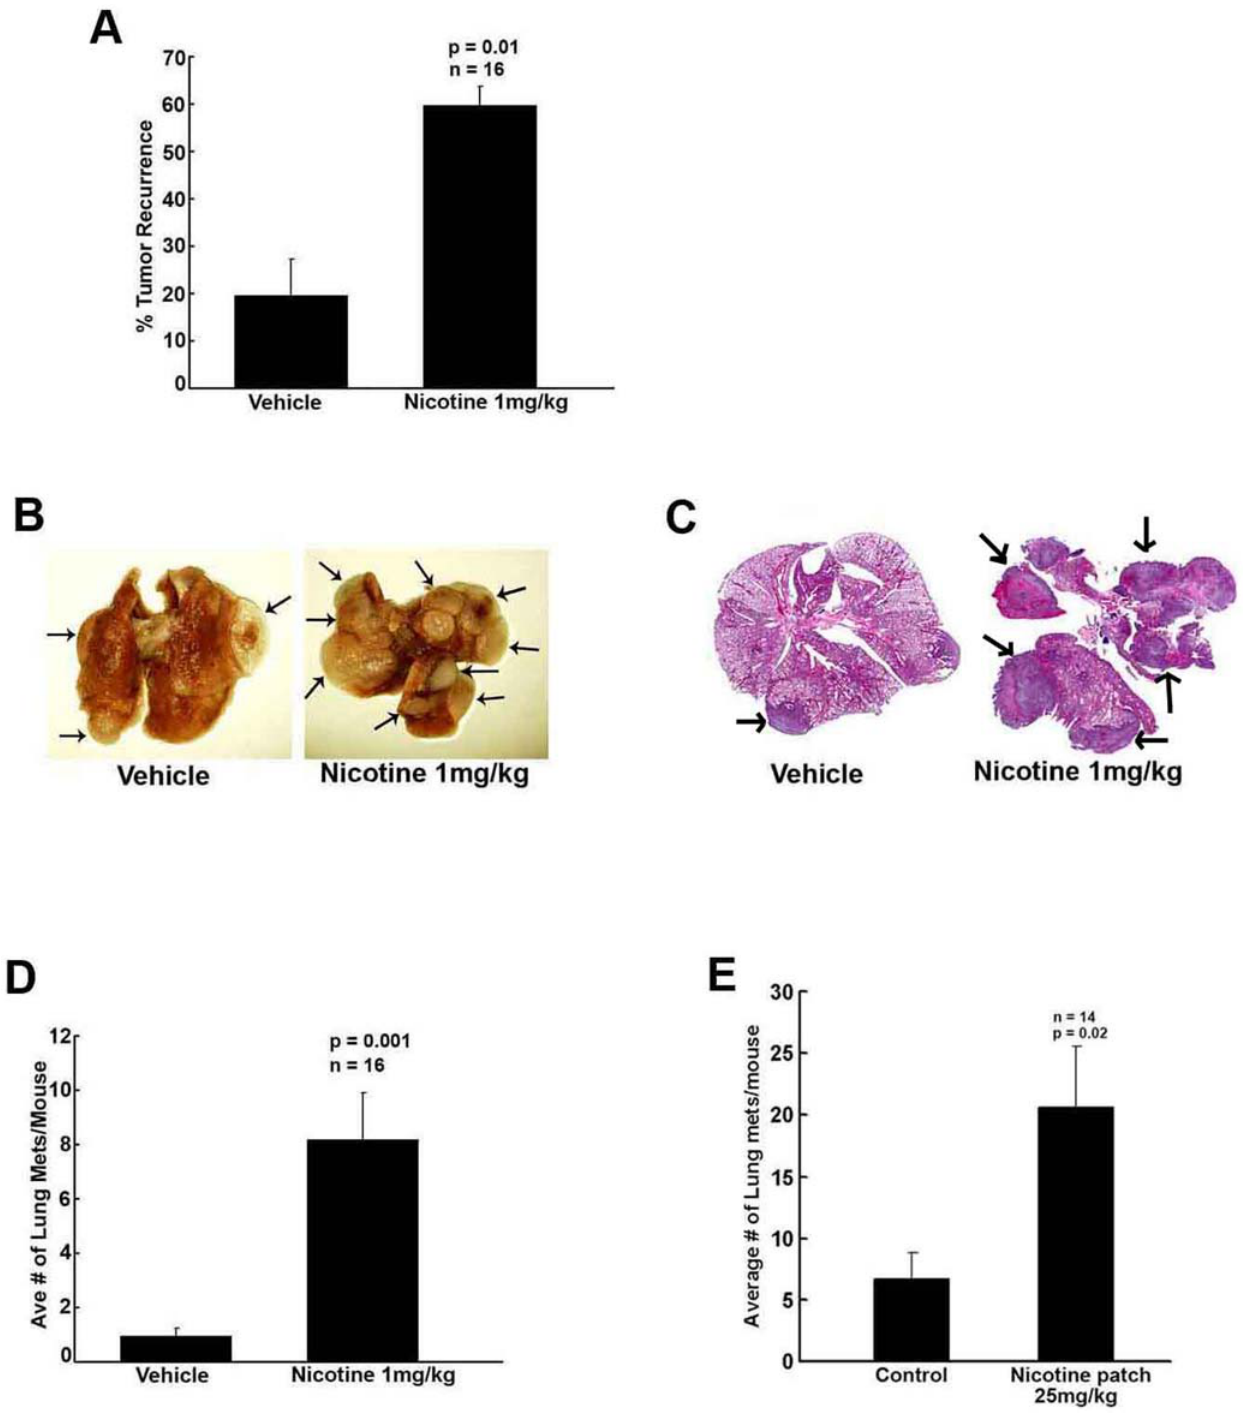
Figure 2. Nicotine increases metastatic potential. (A) Nicotine treated mice (1 mg/kg) displayed higher incidence of tumor recurrence following surgical removal of tumors compared to the vehicle control group, p =0.01, n =16. (B) Nicotine treated mice display significantly more lung metastasis from primary Line1 s.c. tumors. (C) H&E staining of lungs from vehicle and nicotine treated mice, nicotine treated mice display larger tumors as indicated by arrows. (D) Graph displaying the average total number of lung tumors per mouse in vehicle and nicotine (1 mg/kg) treated mice, p=0.001, n =16. (E) Graph displaying the average total number of lung tumors per mouse in control and nicotine patch (25 mg/kg) treated mice, p=0.02, n=16.